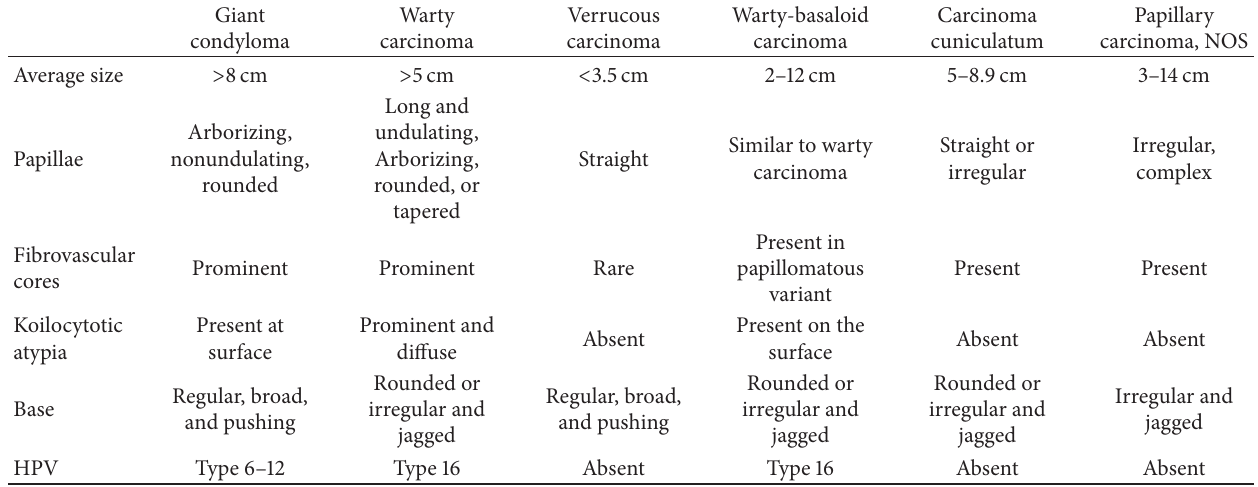
Table 1: Comparison of warty carcinoma and other verruciform